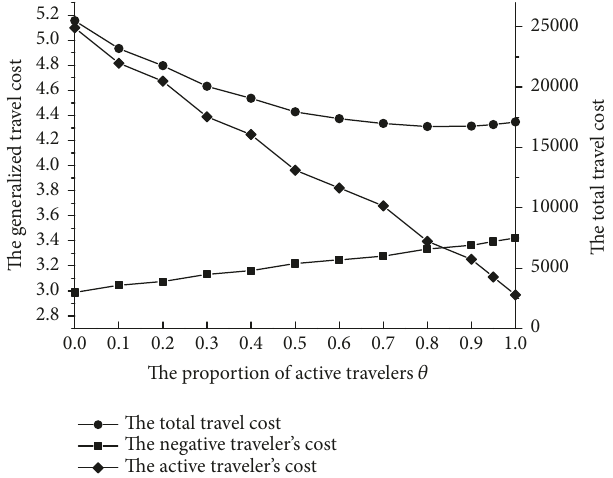
Figure 5: Changes of the travel cost with respect to 𝜃